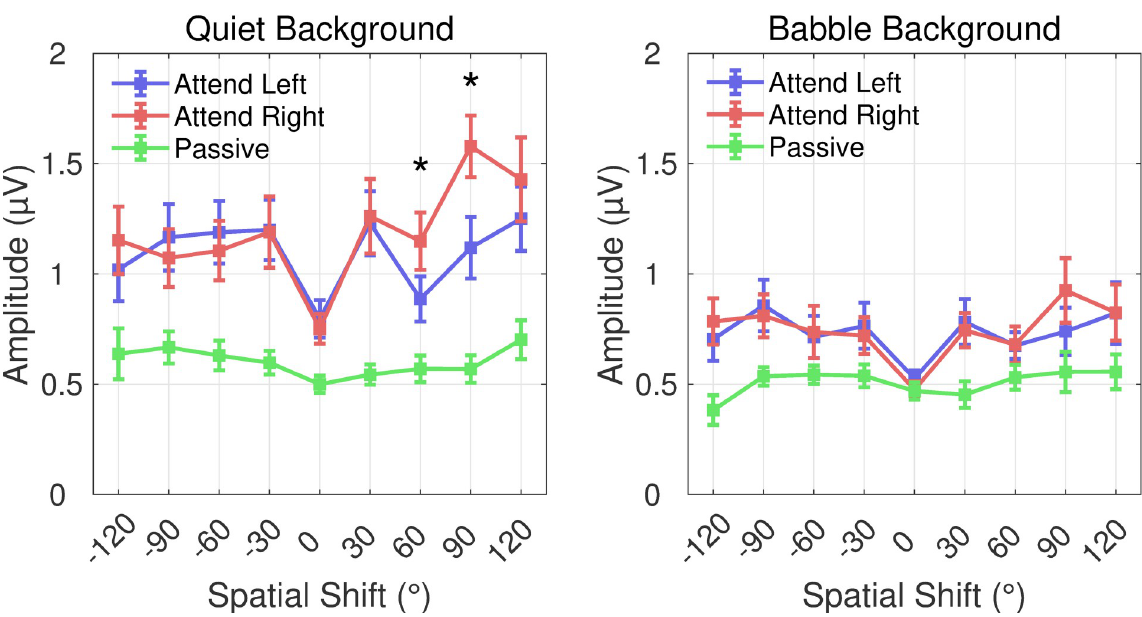
Fig 7. The average GFP activity around 550 ms for a spatial change (displacement between pre and post switch) spanning ± 120˚ in 30˚ increments. All trials were included for the Attend Left (blue) and Attend Right (red) conditions at all locations without regard to button press. Responses in Passive trials (green) were significantly lower than the attention conditions when in Quiet (left panel) and when in Babble background (right